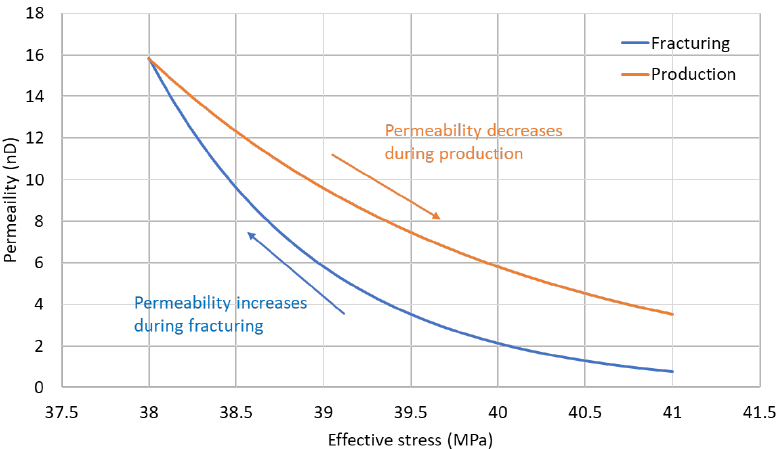
Figure 5. Illustration of stress dependent permeability changing during hydraulic fracturing and production.